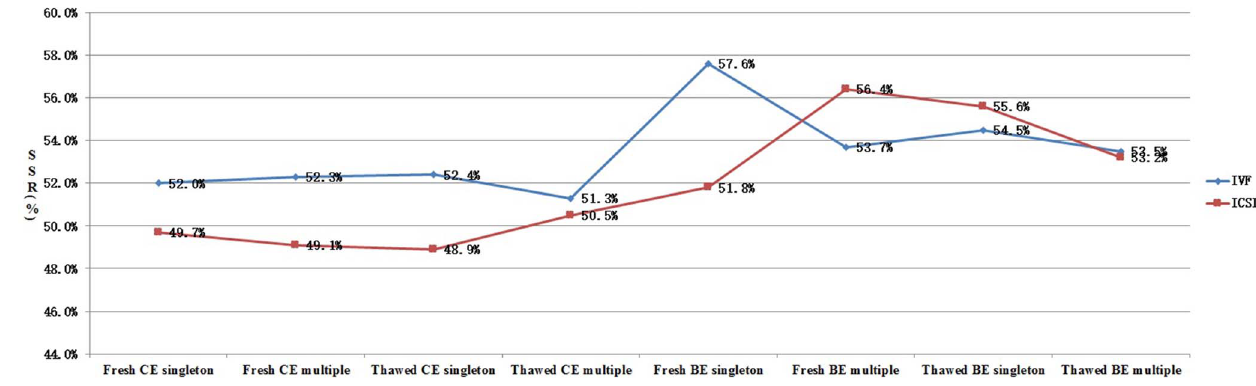
Figure 1. Effect of insemination method (IVF/ICSI) on SSR. SSR= secondary sex ratio; IVF= in vitro fertilization; ICSI= intracytoplasmic sperm injection; CE= cleavage stage embryo; BE= blastocyst embryo.